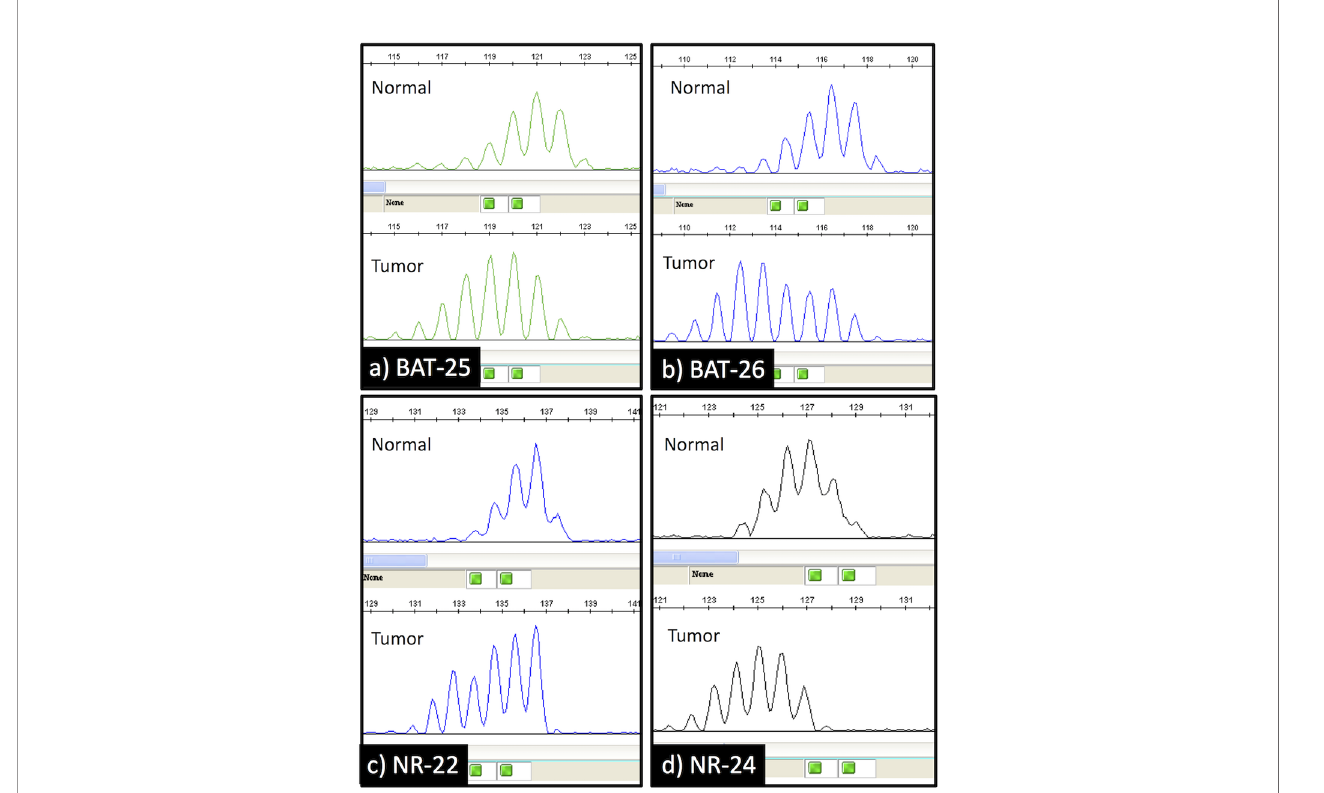
FIGURE 2 | Capillary electrophoresis results of the microsatellite instability analysis. The shift in the size (bases) of the ampli fi cation products in the tumor specimen compared to the normal lung tissue specimen was observed at 4 mononucleotide repeat loci (BAT-25, BAT-26, NR-22, and NR-24).